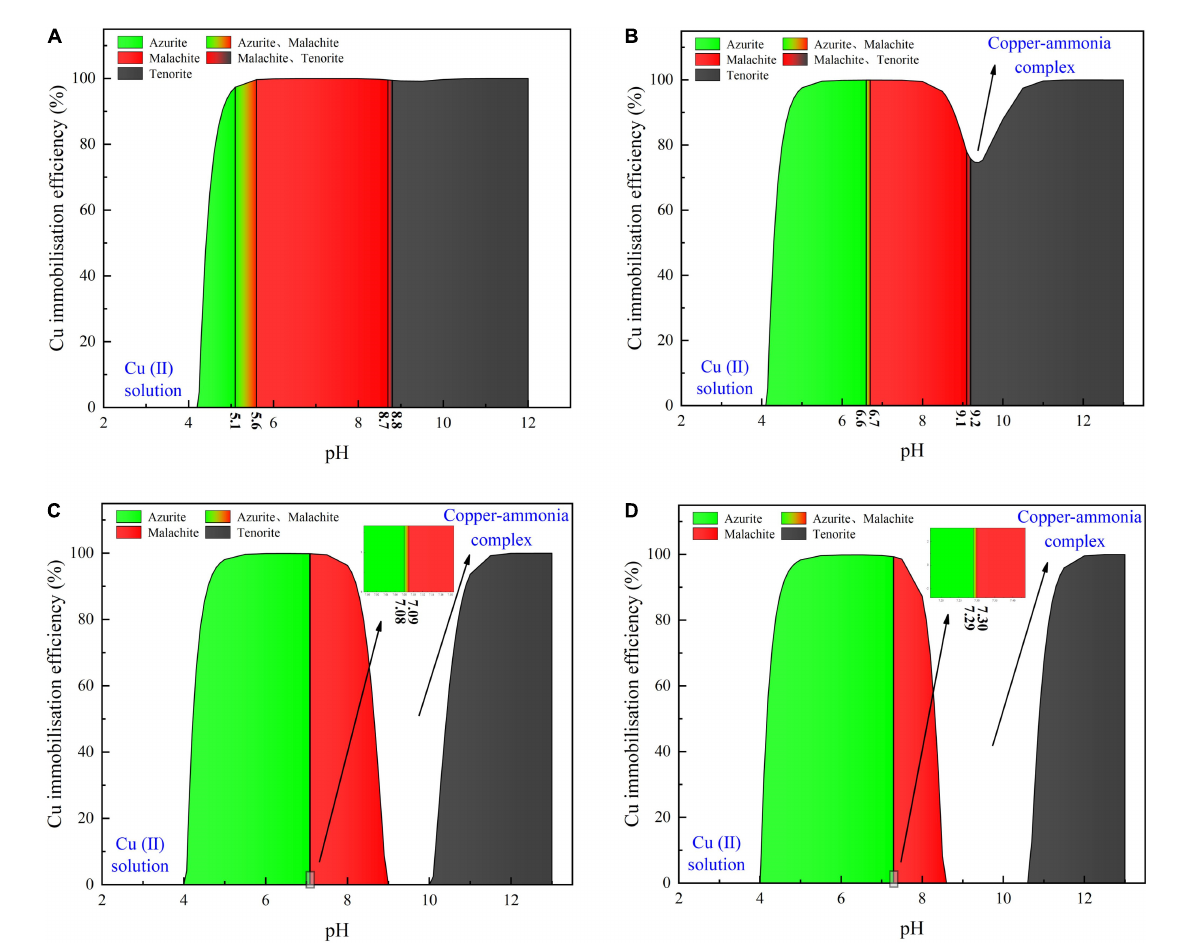
FIGURE7 (A) copper immobilization efficiency vs. pH relationship for the inoculation proportion = 1:9, (B) copper immobilization efficiency vs. pH relationship for the inoculation proportion = 1:3, (C) copper immobilization efficiency vs. pH relationship for the inoculation proportion = 1:1, and (D) copper immobilization efficiency vs. pH relationship for the inoculation proportion = 3:1 [Cu(NO 3 ) 2 concentration = 20